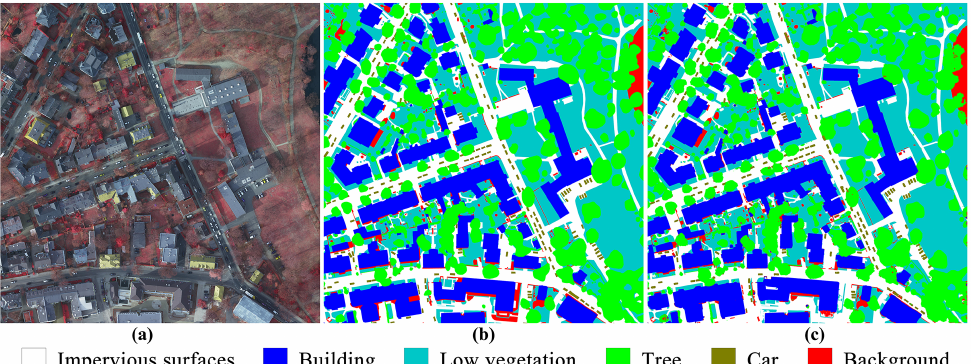
Figure 6. The segmentation result of XANet on the Postdam dataset: ( a ) Image; ( b ) Ground truth; and ( c ) Segmentation